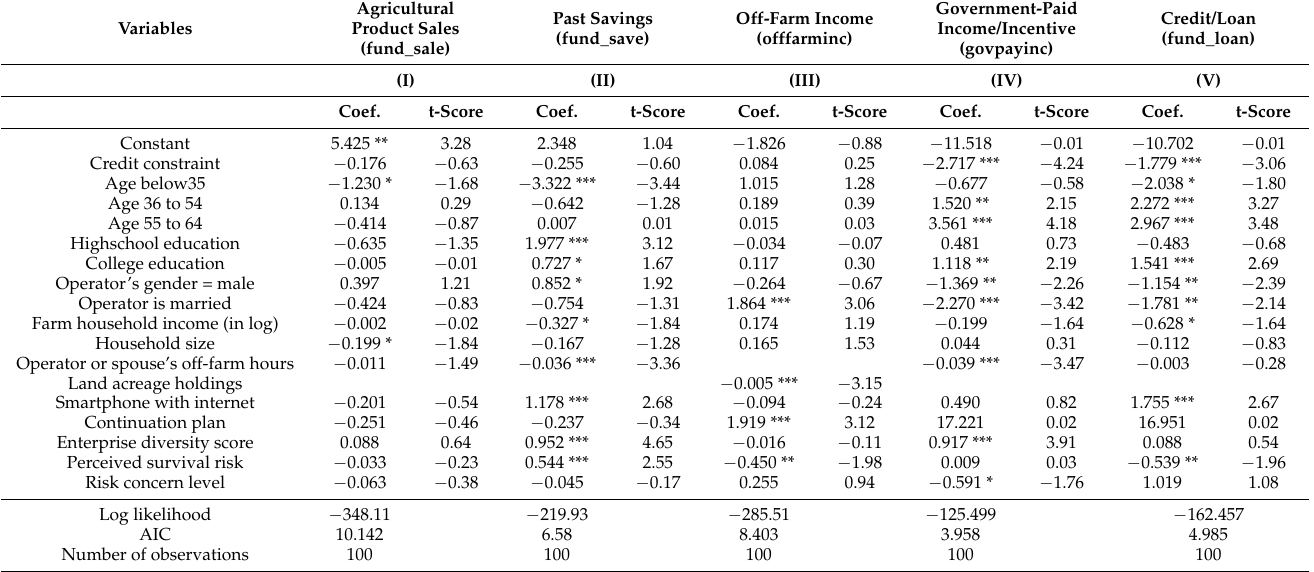
Table 2. Factors influencing the extent of various financing sources used to finance farm expenses (dependent variables: extent of use (%) fund use from the indicated